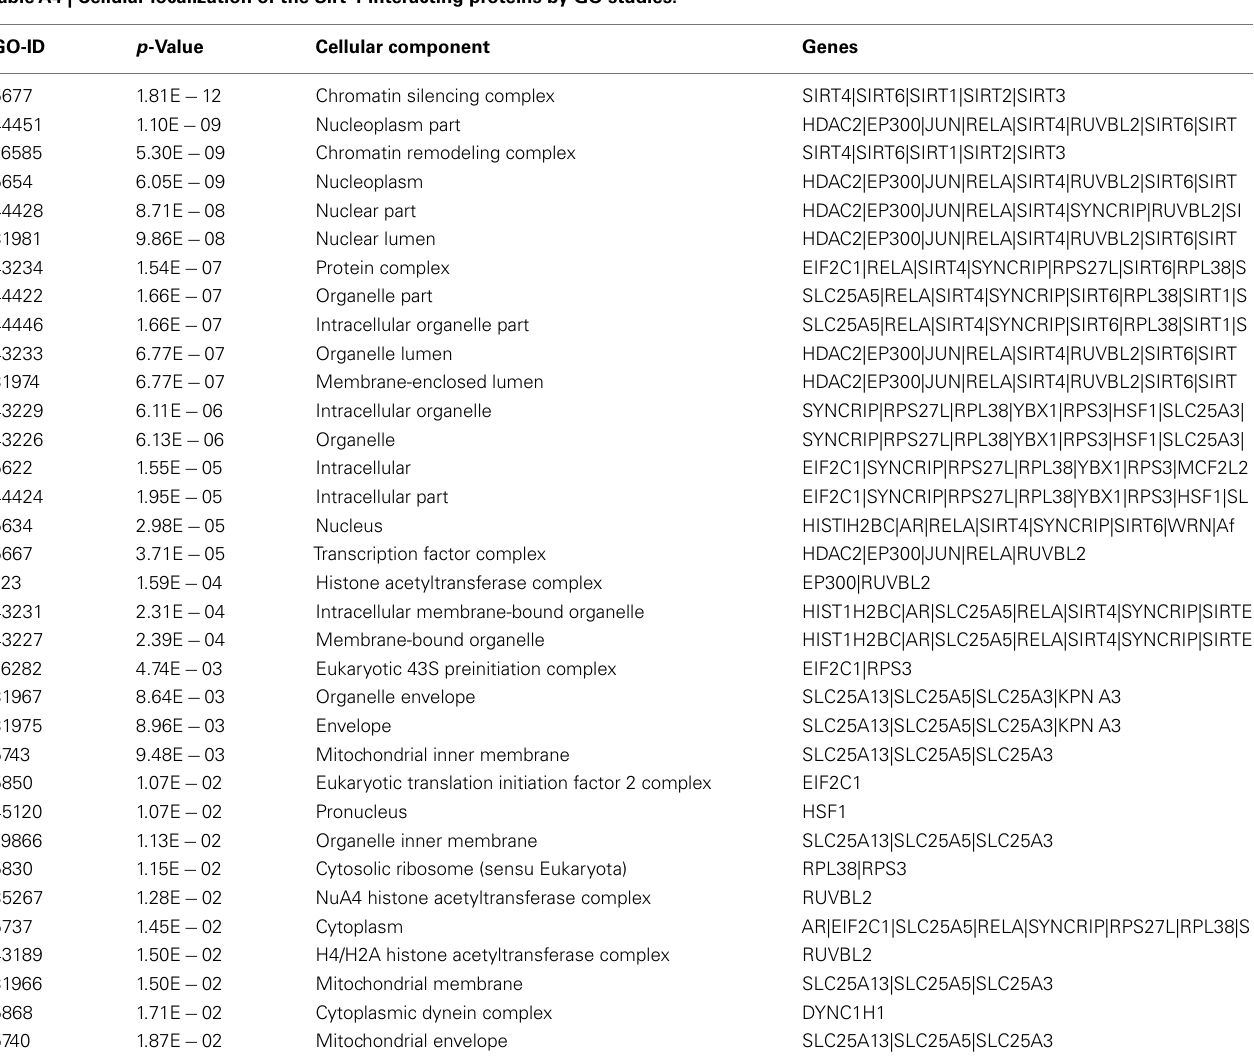
TableA4 | Cellular localization of the Sirt-1 interacting proteins by GO